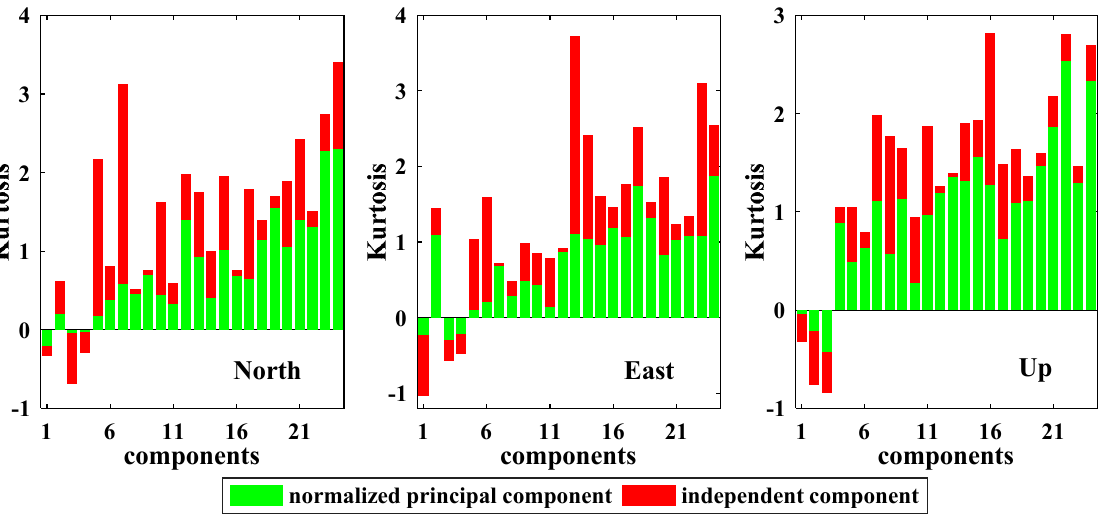
Figure 4. Map of kurtosis on the normalized principal components and independent components.